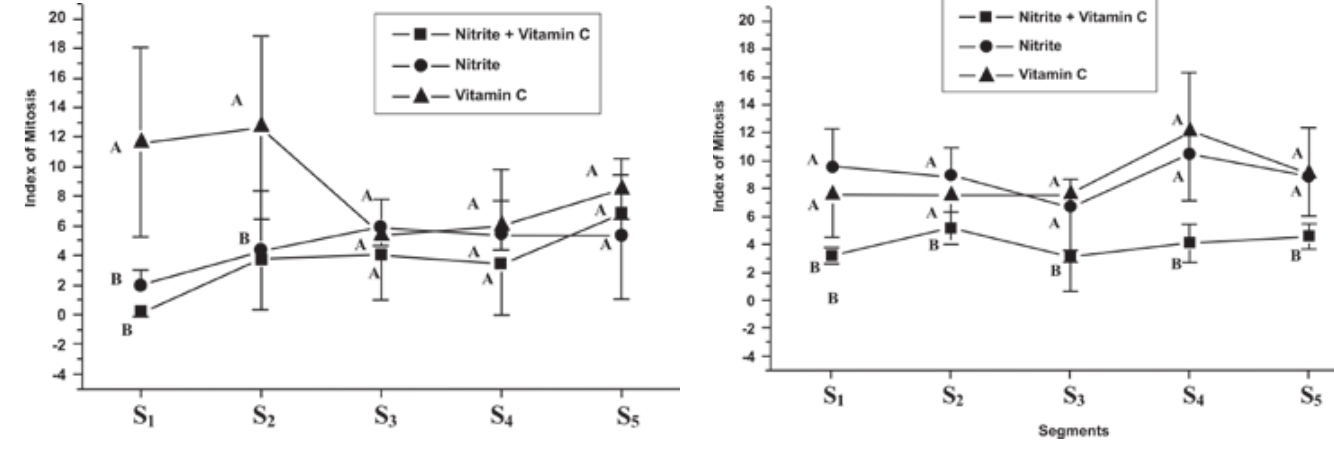
FIGURE 7 - Means and standard deviations of the Index of Mitosis in the segments according to group and